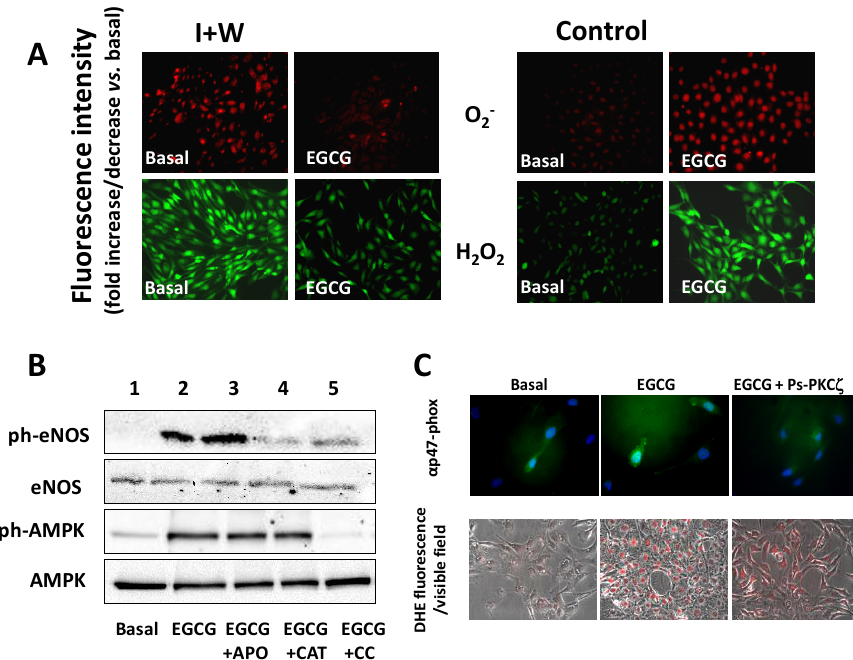
Figure 2. Effects of EGCG on ROS levels and signaling pathways related to endothelial NO synthase (eNOS) activation in endothelial cells. ( A ) EGCG decreases ROS overproduction in endothelial cells exposed to insulin resistance (high insulin levels, I + inhibition of PI 3 K wortmannin, W), but increases both H 2 O 2 and O 2 − in healthy endothelial cells (control). Red fluorescence indicates O 2 − ; green fluorescence indicates H 2 O 2 ; ( B ) EGCG increases phosphorylation of eNOS and AMPK in control BEC with a signaling that requires H 2 O 2 and AMPK. Apocynin (APO) is a NADPH oxidase inhibitor; Catalase (CAT) is a H 2 O 2 scavenger; Compound C (CC) is an AMPK inhibitor ( C ) EGCG increases the membrane localization of p47 phox in healthy endothelial cells via a PKC ζ -mediated signaling. Green fluorescence indicates p47 phox ; blue fluorescence indicates cell nucleus; PS-PKC ζ is an inhibitor of PKC ζ .